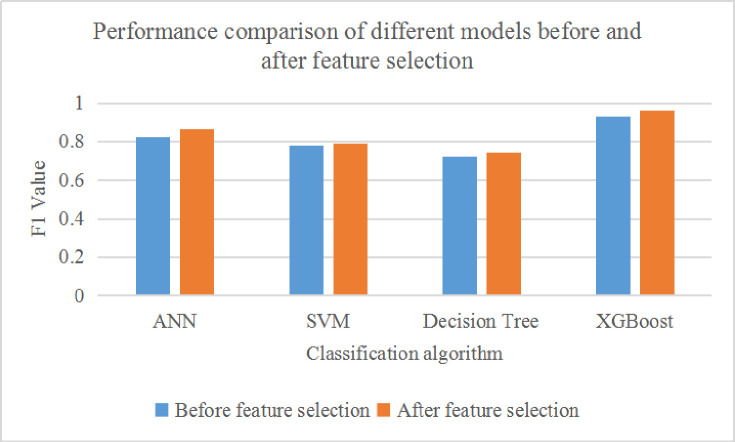
Performance comparison of different models before and after feature selection.